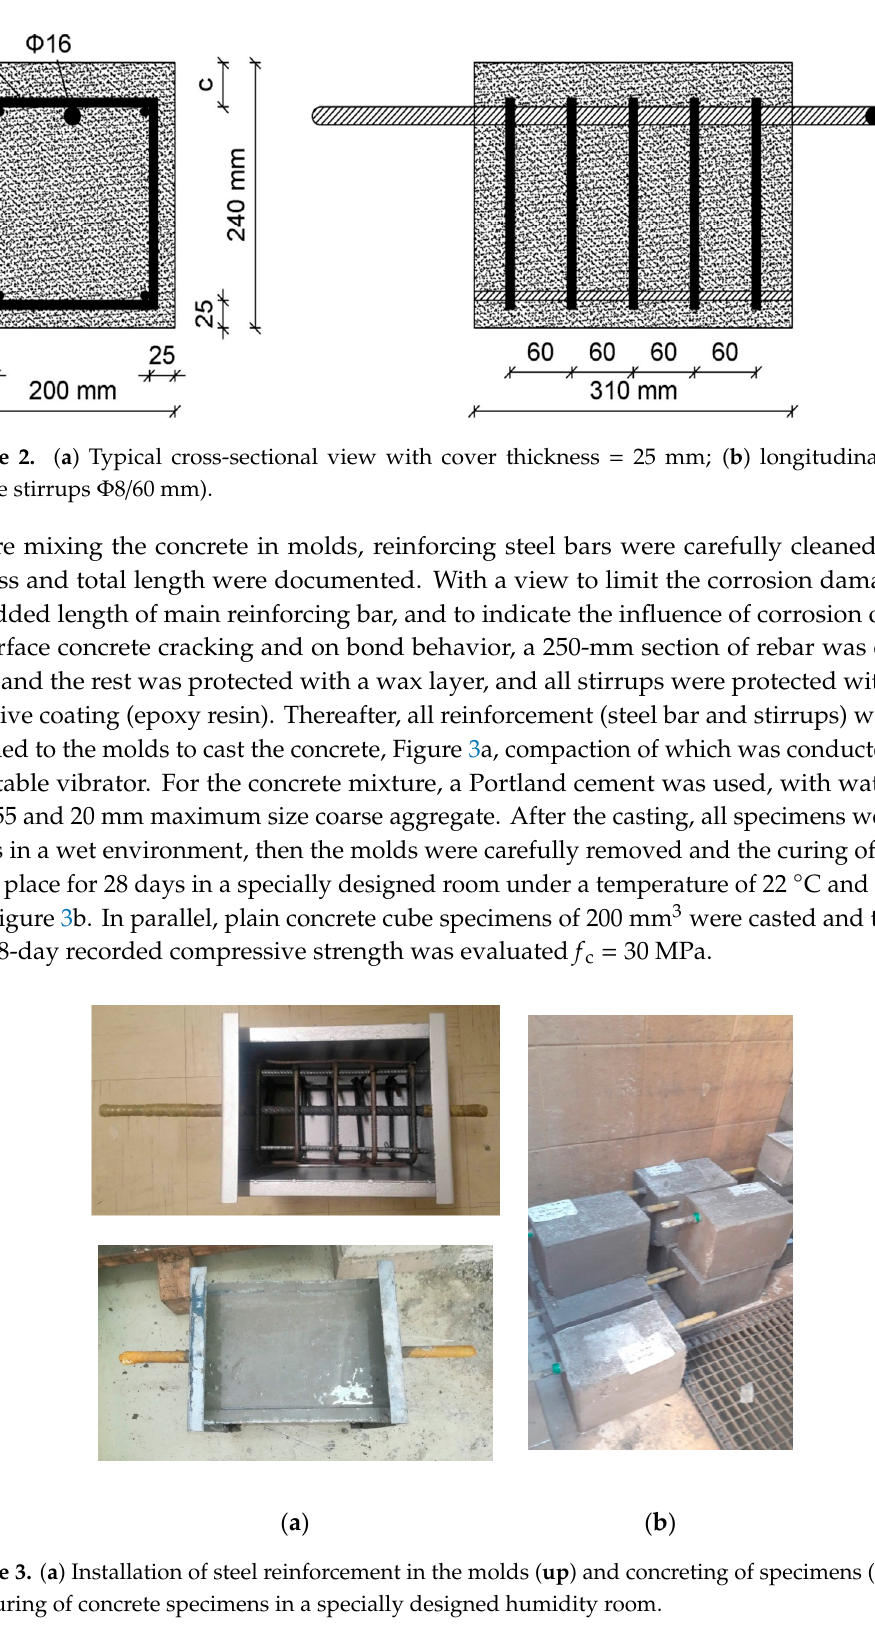
Figure 3. ( a ) Installation of steel reinforcement in the molds ( up ) and concreting of specimens ( down ). ( b ) Curing of concrete specimens in a specially designed humidity room.